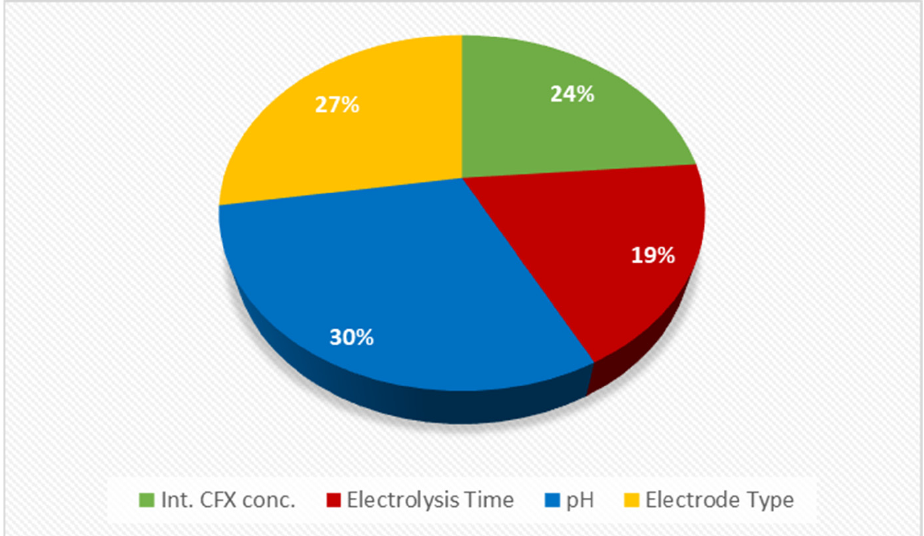
Figure 6. Sensitivity Analysis of ANN Input Variables.